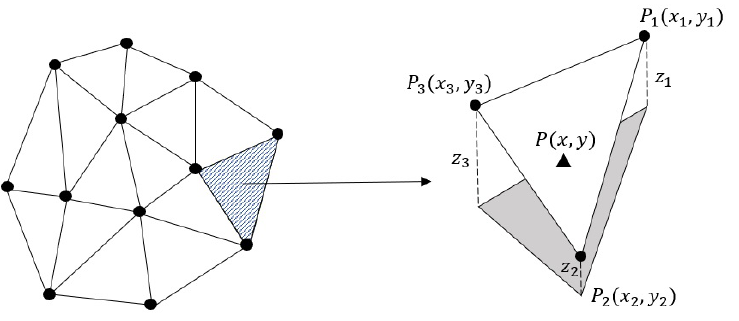
Figure 2. Delaunay-based interpolation on a set of points. First, a Delaunay triangulation is carried out on the points. Then, a plane is fitted to each triangle, and finally, the value for points on each of them is obtained based on the fitted